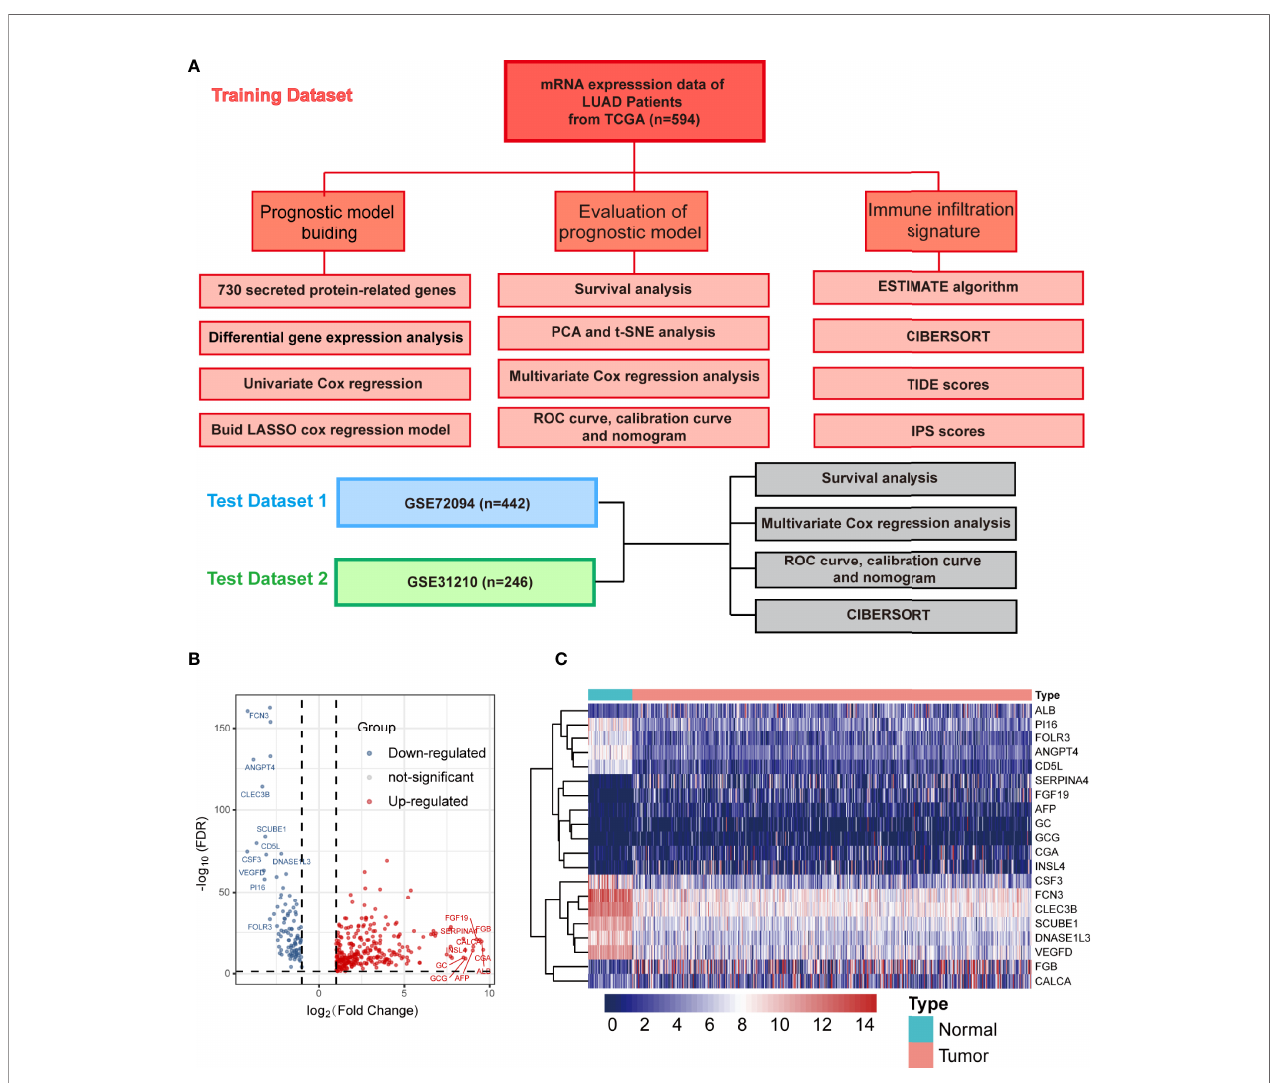
FIGURE 1 | Screening for secreted protein-related genes in The Cancer Genome Atlas lung adenocarcinoma cohort. (A) Flow diagram of the research process. (B) Volcano plot of differentially expressed secretory protein genes (DESPRGs) between lung adenocarcinoma and normal lung tissues; the top 10 genes with the highest and lowest expression are labeled respectively. (C) Heat map diagram of the top 10 DESPRGs in lung adenocarcinoma compared with normal lung tissue. Red indicates a high expression, while blue indicates a low